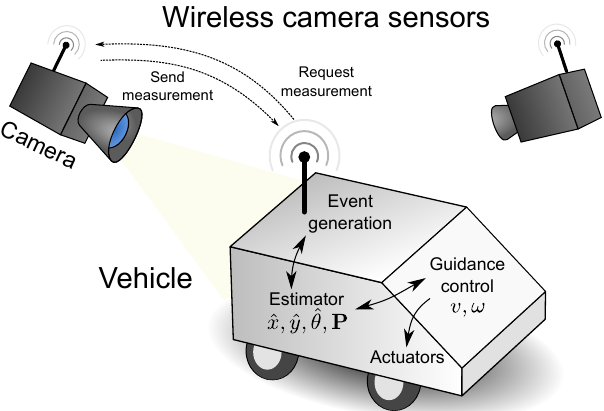
Figure 1. General description of the system showing the most important elements: the vehicle (controller and estimator) and sensors linked by a wireless